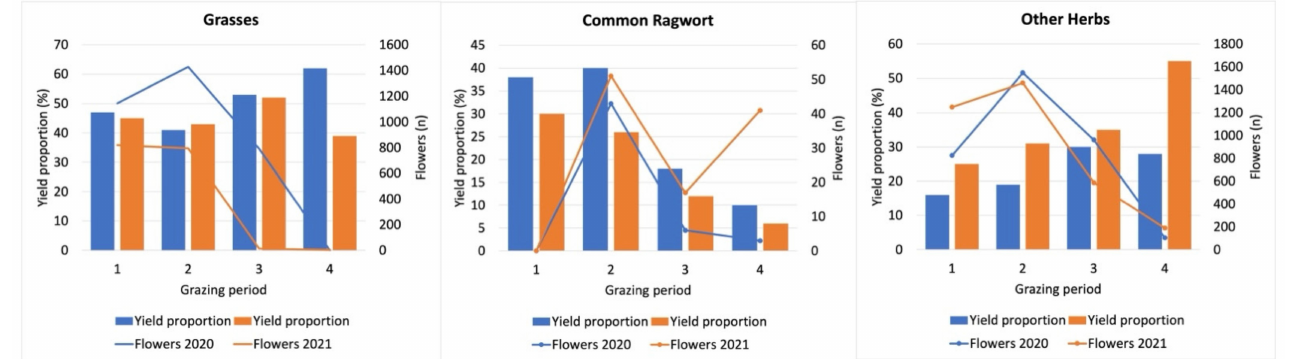
Figure 6. Mean yield proportions (in percent; units left ordinate) and flowers ( n ; right ordinate) of common ragwort, other herbs, and grasses. Data obtained from botanical plots.